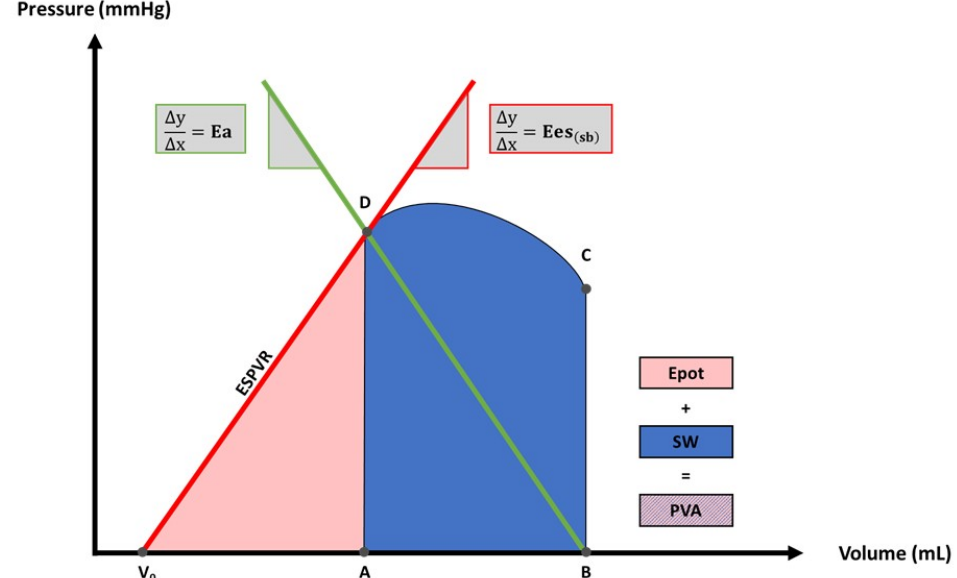
Figure 3. Non-Invasive Left Ventricular Pressure–Volume Loop. ESV, end-systolic volume; EDV, end-diastolic volume; P es , end-systolic blood pressure. A (ESV/0 mmHg), B (EDV/0 mmHg), C (EDV/P es ), D (ESV/P es ). A–B, diastolic filling; B–C, isovolumic contraction; C–D, ejection; D–A, isovolumic relaxation. ESPVR, end-systolic pressure–volume relationship; Ees (sb) , end-systolic elastance derived by single-beat technique; V 0 , intersection between ESPVR and x axis; Ea, arterial elastance; Epot, potential energy; SW, stroke work; PVA, pressure–volume